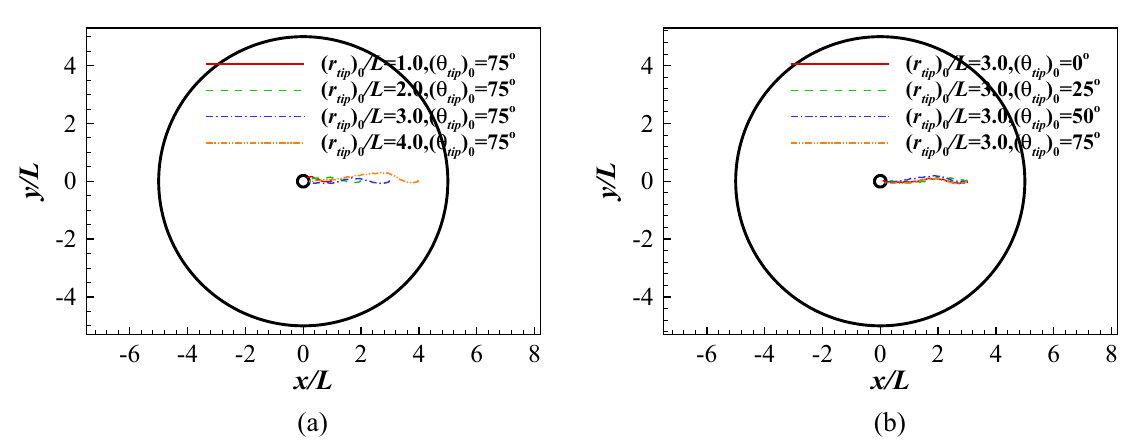
Figure 8. Point-to-point swimming by considering the influence of the flow dynamics in the states: ( a ) the traces of the head during different learning stages; and ( b ) the total number of periods the fish maintains in the swimming area for all episodes considered.